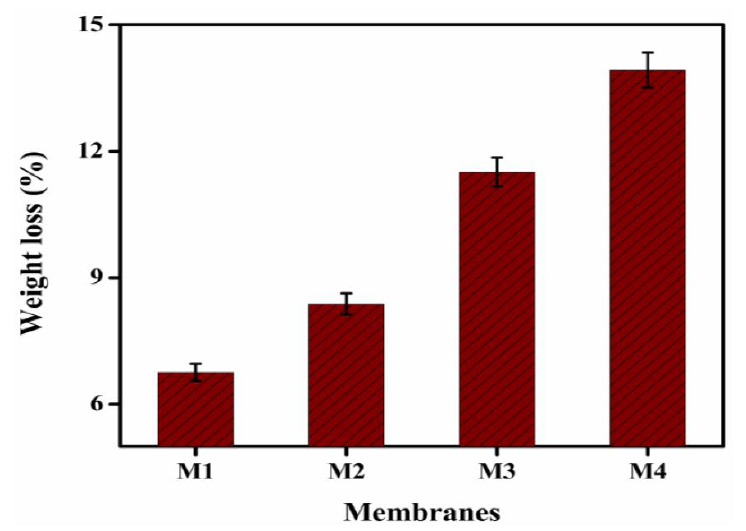
Figure 11. Chemical stability of membrane M1 to M4 after immersion in 2 M HCl for two weeks at room temperature.